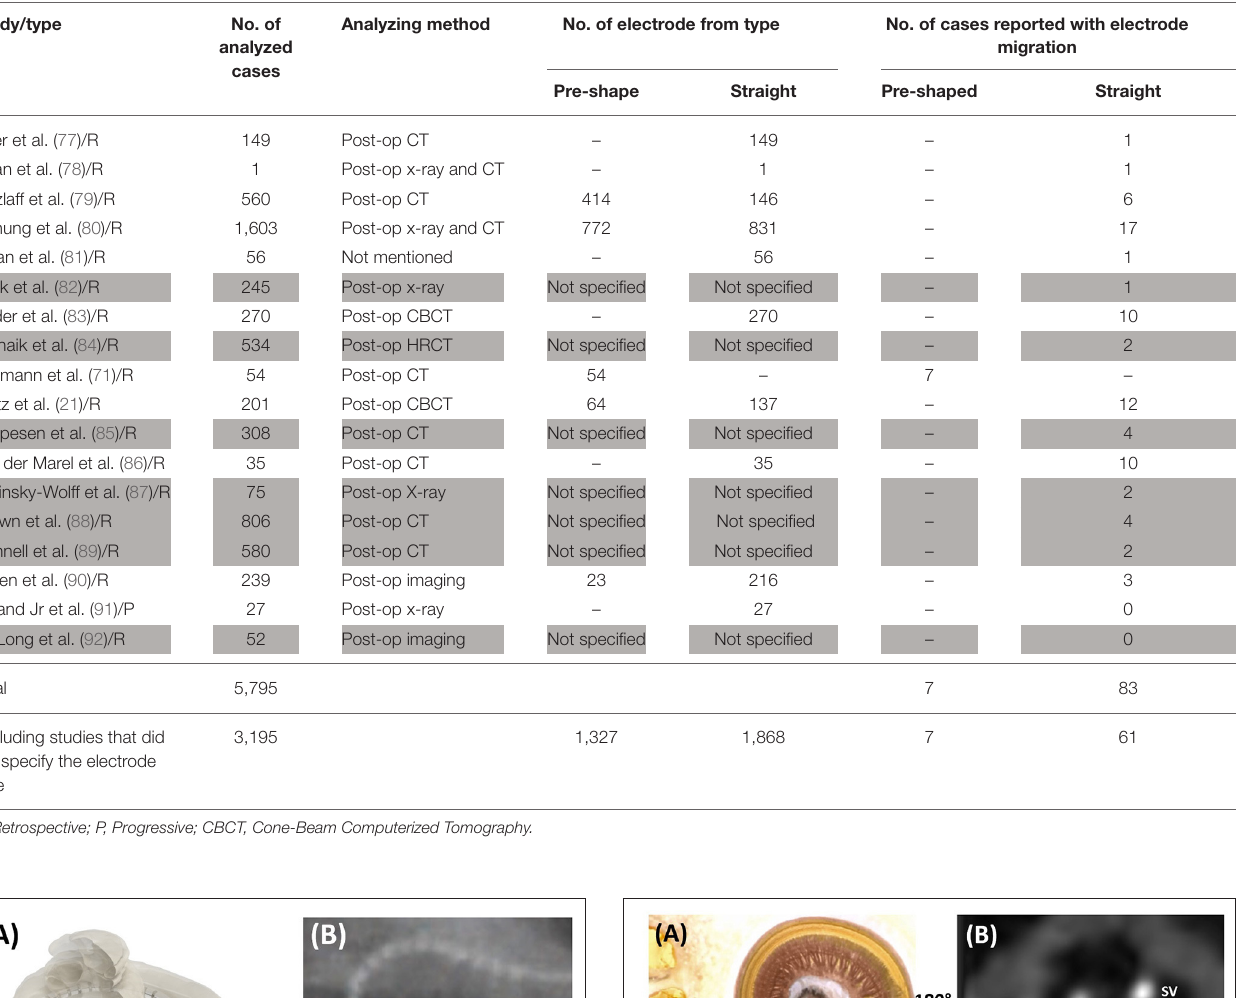
This occurs mainly between 90 and 180 ◦ of angular insertion depth, causing a scalar deviation as pointed by a black arrow in Figure 4A and a red arrow in Figure 4B . Electrode scalar deviation is associated with fibrous tissue growth and osteo-neogenesis with the cochlea. Most importantly, ESD has been associated with irreversible degeneration of neuronal cells as detected from the histological